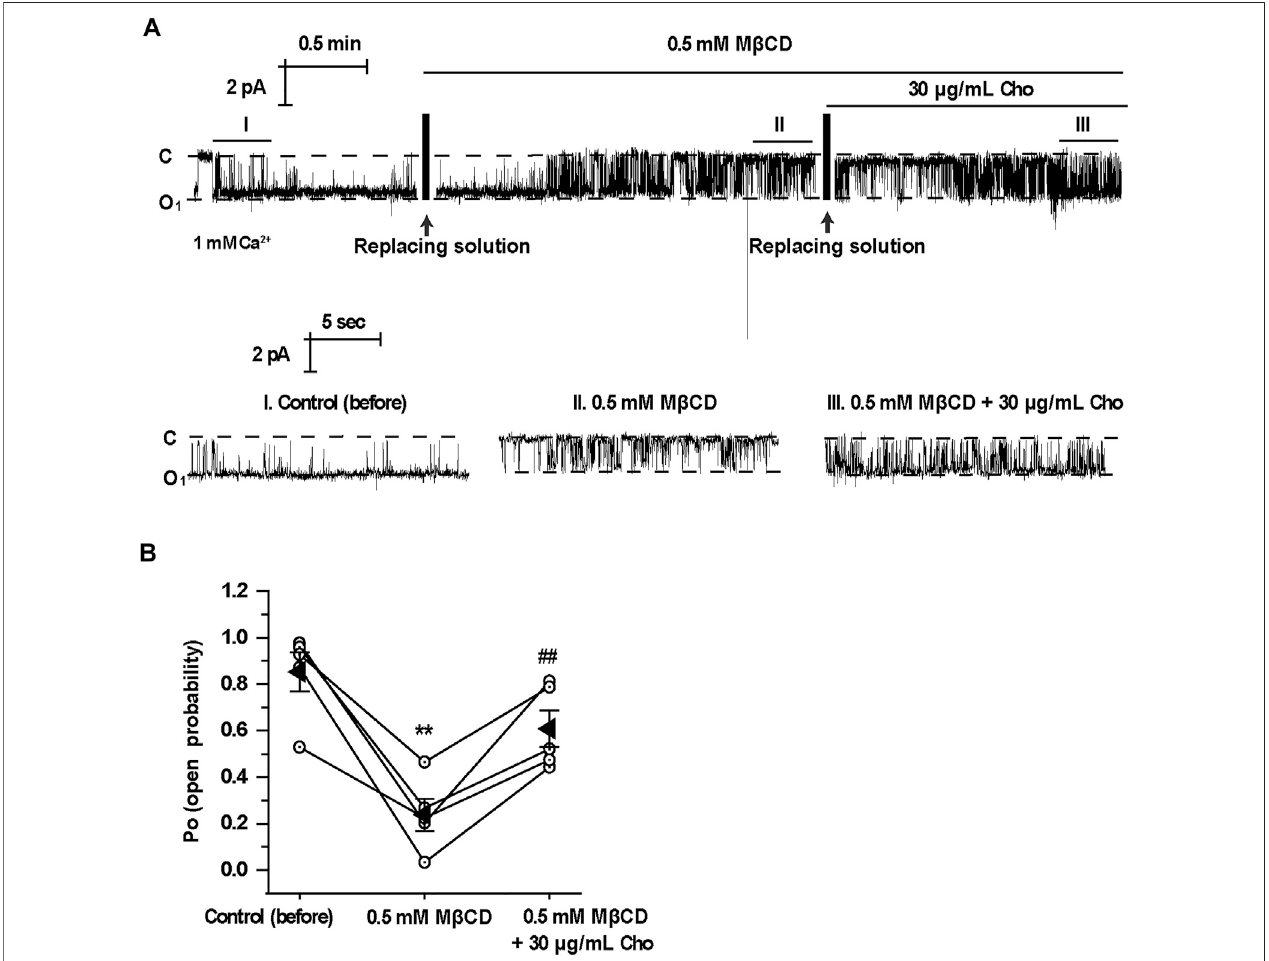
FIGURE 3 | Application of M β CD to the cytoplasmic bath decreases TRPM4 channel activity which is reversed by exogenous cholesterol. (A) A representative singlechannelrecordingfromaninside-outpatchshowsTRPM4activitybeforeandafterreplacementofcontrolcytoplasmicbathsolution fi rstwithasolutioncontaining 0.5 mM M β CD and then with a solution containing 30 μ g/ml cholesterol. “ C ” indicates channel at the closed state. “ O ” indicates single-level openings. “ I, II, and III ” are zoom-ins of the single-channel recording. (B) Summary plots of TRPM4 channel P O under each indicted condition. n (cid:2) 5 paired experiments, ** P < 0.01, signi fi cantly different with control; ## P < 0.01, signi fi cantly different with cells treated with 0.5 mM M β CD.